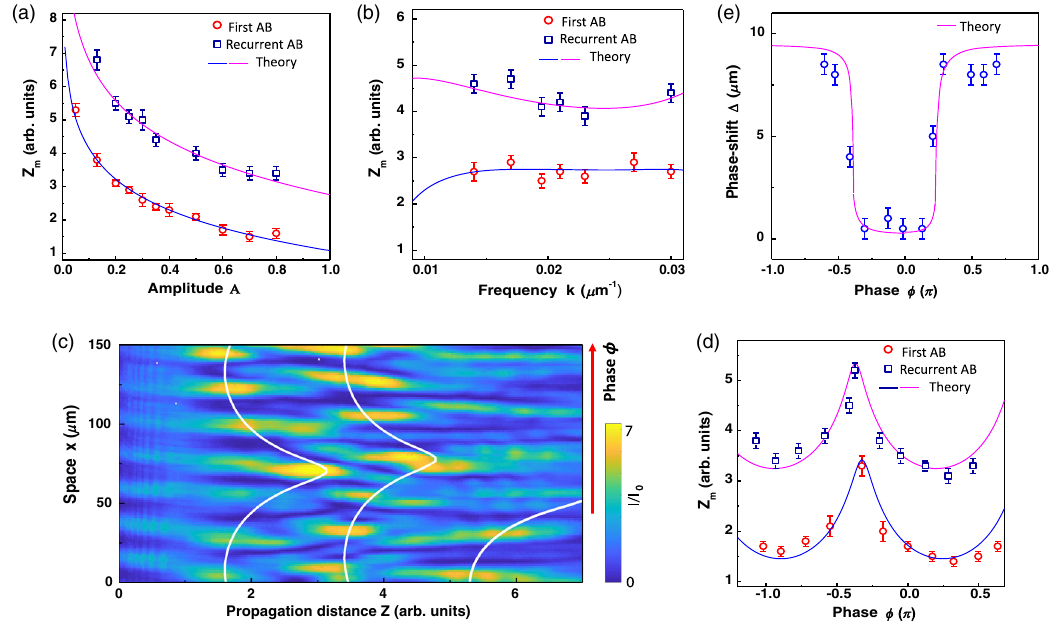
FIG. 3. Properties of the recurrent behavior. Recurrence partial period measured (dots) by varying (a) the amplitude of the input excitation ( k ¼ 0 . 023 μ m − 1 ) and (b) the frequency of the input mode ( A ¼ 0 . 3 ). (c) Evolving intensity distri- bution detected for an input phase that varies along x ( k ¼ 0 . 030 μ m − 1 ). White lines interpolate local maxima and serve as guides. (d) Z m as a function of the initial dephasing. Blue and magenta lines in panels (a) – (d) are fitting functions according to Eq. (3) (see the Appendix). (e) Recurrence phase shift varying the input phase: measured sharp transitions (dots) and predicted behavior (line).